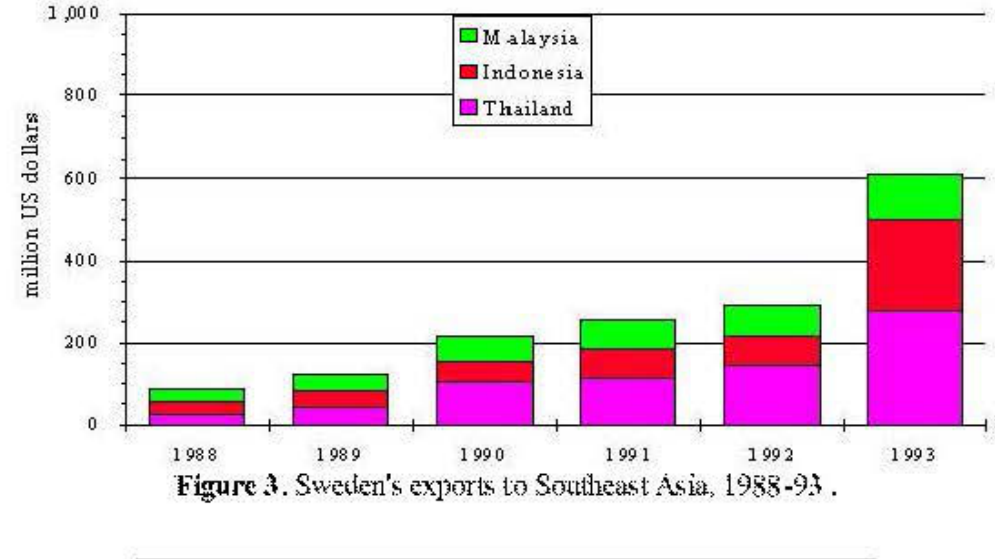
Figure 4. Finland's expm·ts to SoutheastAsi.a, 1988-93